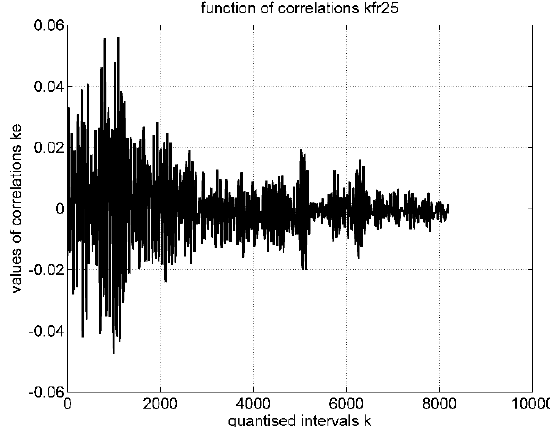
Appl. Sci. 2019 , 9 , x FOR PEER REVIEW Figure 10. Normalized inter-covariance function of the 2nd and 5th vibration accelerations vectors. Figure 10. Normalized inter-covariance function of the 2nd and 5th vibration accelerations vectors. Figure 10. Normalized inter-covariance function of the 2nd and 5th vibration accelerations vectors.